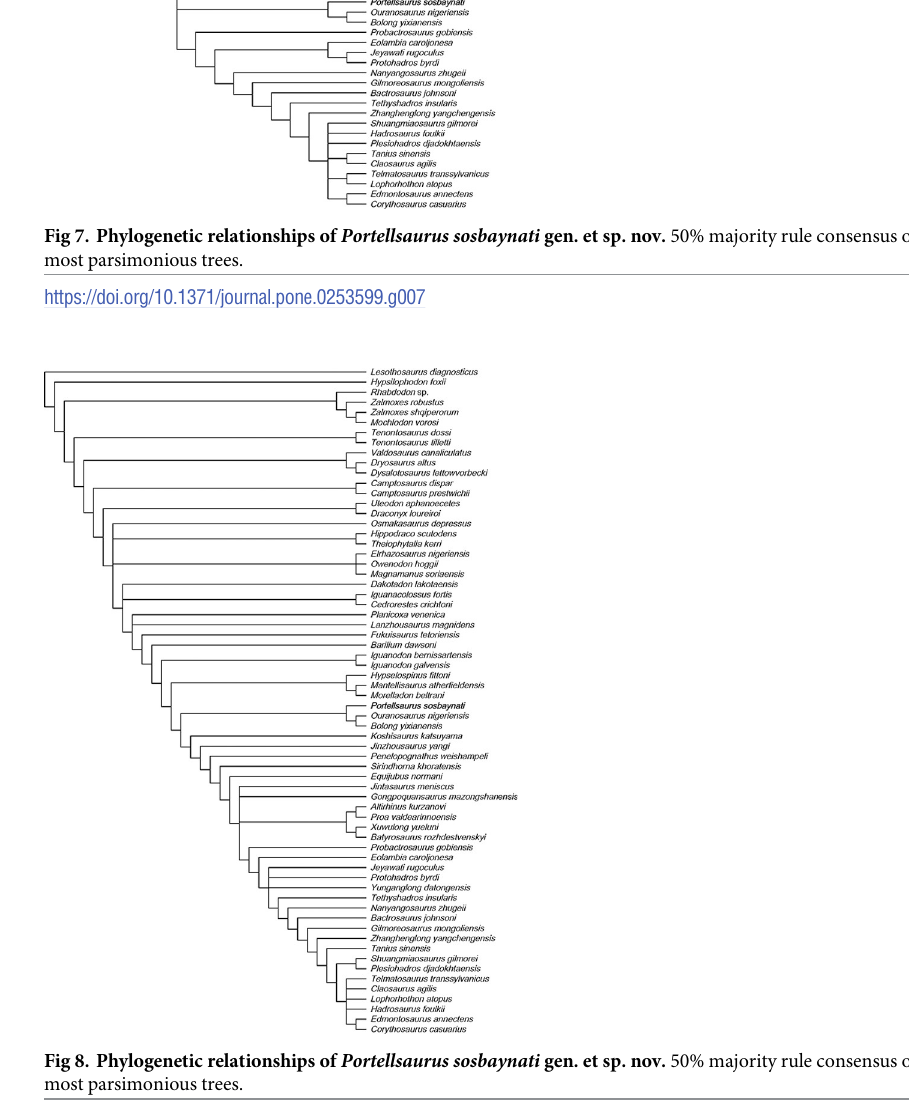
PLOS ONE | https://doi.org/10.1371/journal.pone.0253599 July 7,